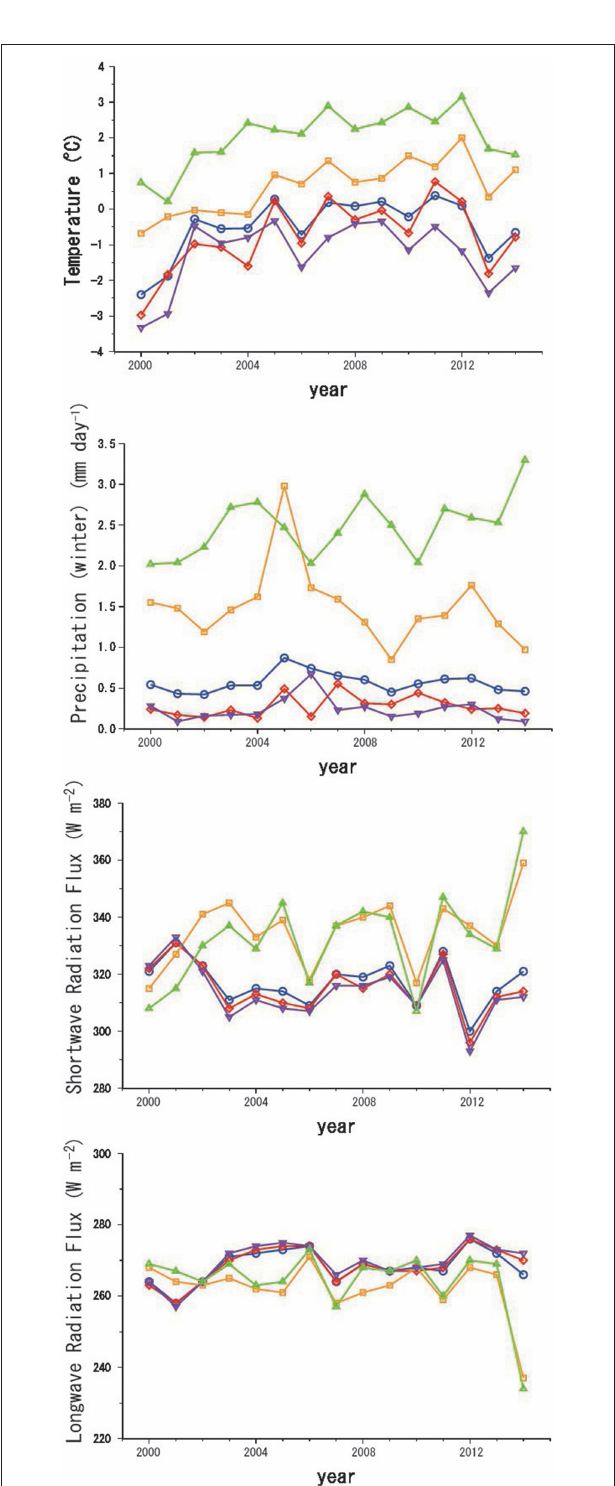
FIGURE 5 | Annual variability of temperature, precipitation, shortwave radiation flux, and long-wave radiation flux calculated from NCEP/NCAR reanalysis data (Kalnay et al., 1996) in whole region (blue circle) and northwestern (red diamond), northeastern (purple inverted triangle), southwestern (orange square), and southeastern (green triangle) regions from 2000 to